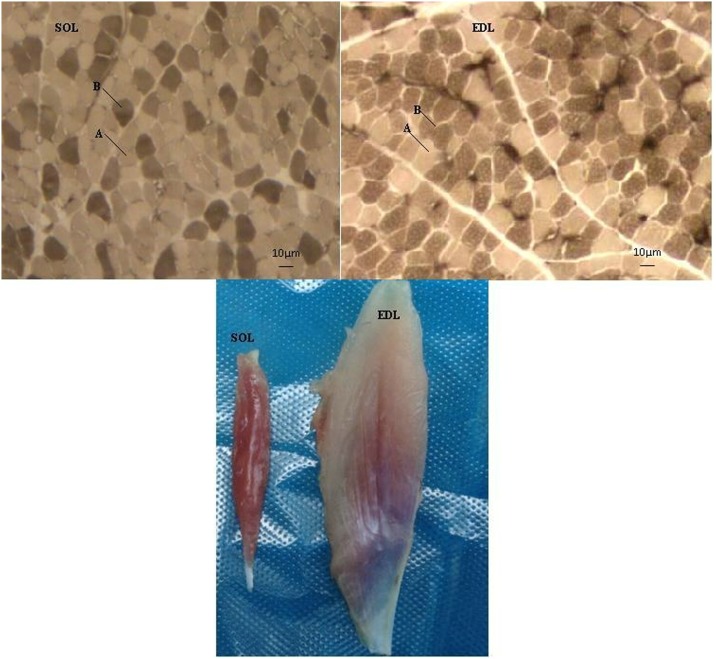
Morphological and fiber-type variations in SOL and EDL muscle samples of Qingyuan partridge chickens.A: white fiber, B: red fiber; Bar: 10 μm.